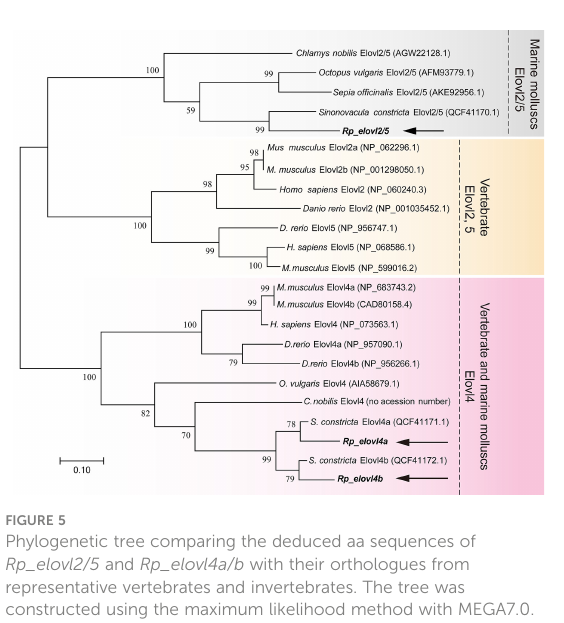
FIGURE 5 Phylogenetic tree comparing the deduced aa sequences of Rp_elovl2/5 and Rp_elovl4a/b with their orthologues from representative vertebrates and invertebrates. The tree was constructed using the maximum likelihood method with MEGA7.0. The horizontal branch length is proportional to aa substitution rate per site. The numbers represent the frequencies (%) with which the tree topology presented was replicated after 1,000 iterations.